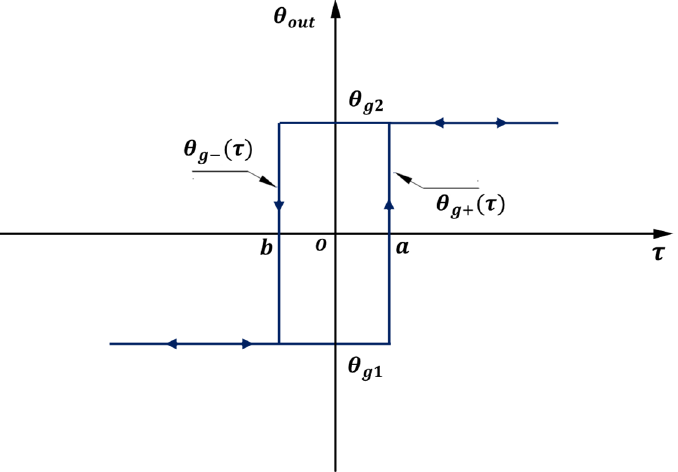
Figure 5. Geometric error curve. Assume the rotation angle generated by friction in the hysteresis module is θ f ( τ ) , which is also the combination of a rising curve θ f + ( τ ) and falling curve θ f − ( τ ) , as shown in Equation (8). Then, Equation (3) can be expressed as Equation (9), and Equation (4) represents Equation (10).